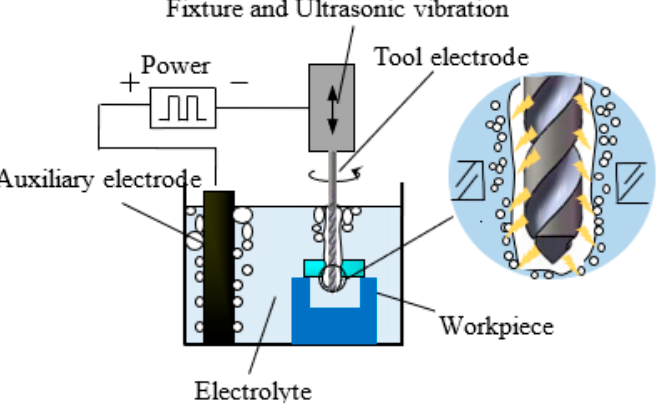
Figure 1. Schematic diagram of electrochemical discharge machining (ECDM).